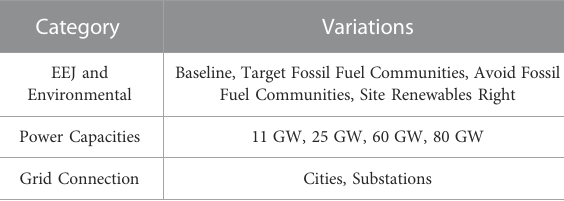
TABLE 4 Overview of scenarios presented in this